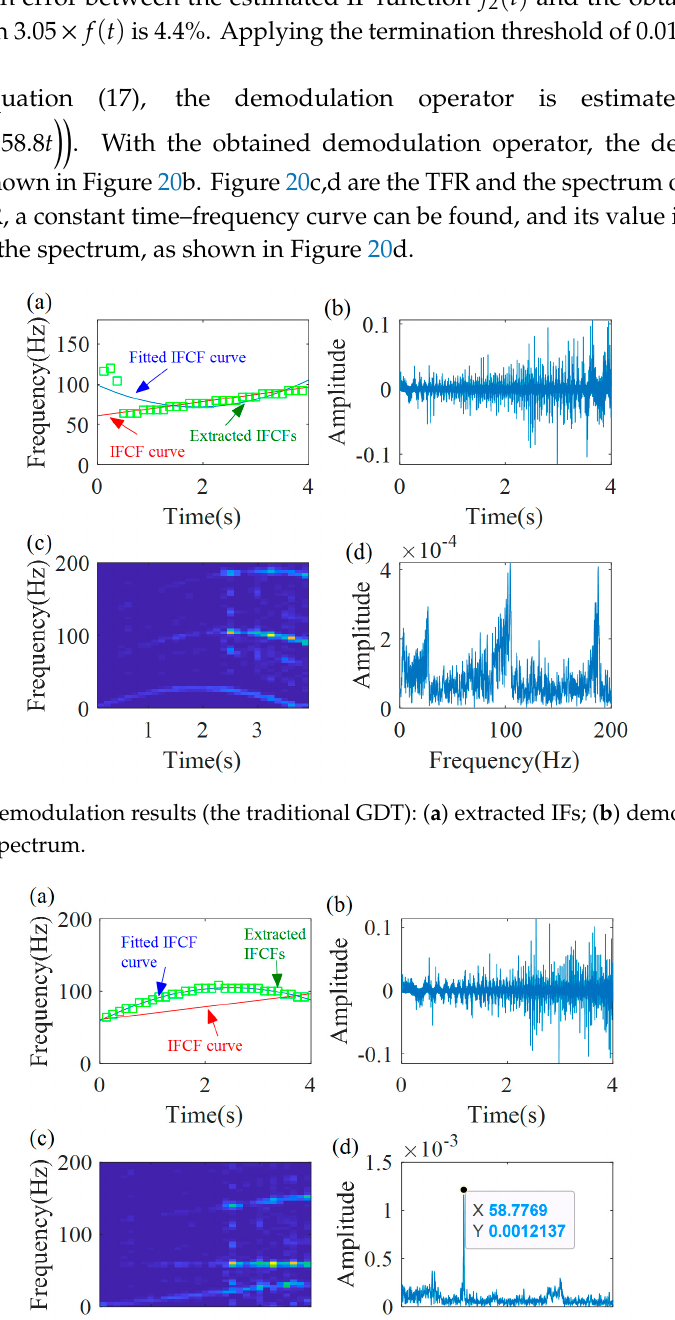
Figure 20. Multiple demodulation results: ( a ) calculated instantaneous fault characteristic frequency (IFCF) curve; ( b ) demodulation signal; ( c ) TFR; and ( d ) the spectrum. Then, the proposed technology is further validated for estimation of IFs of the second and the third harmonics of outer race defect frequency. Figure 21a,b is the TFR and the spectrum of the demodulated signal, related to the second harmonic. Figure 21c,d is the TFR and the spectrum of the demodulated signal, related to the third harmonic. A constant time-frequency ridge and a peak can be detected in the TFR and the spectrum of demodulated signal, related to the second harmonic (Figure 21a,b). The peak frequency is 117.7 Hz, which is very close to the value 121.4 Hz, estimated by the speed sensor. Similarly, a constant time-